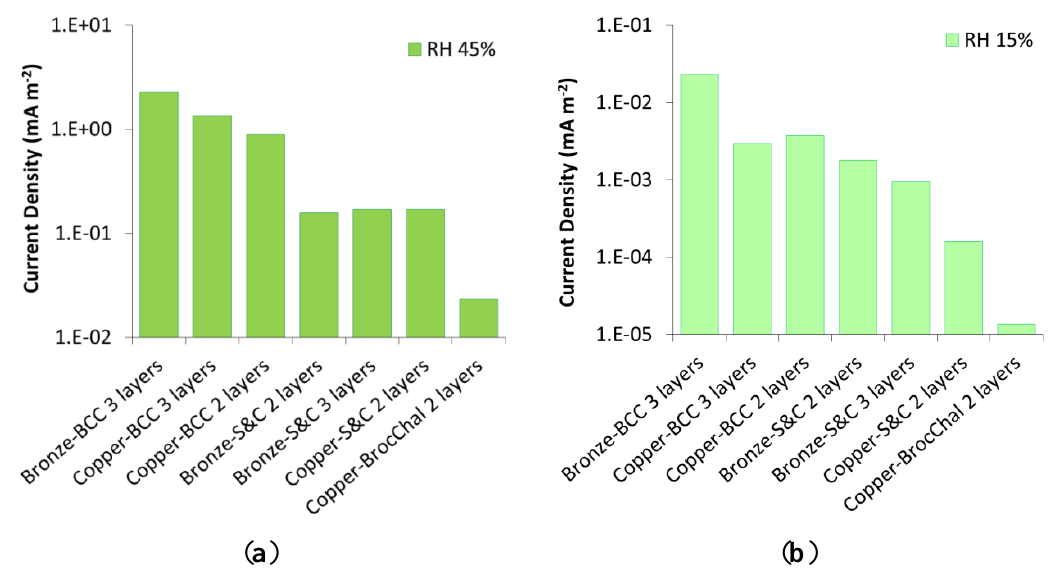
Figure 12. Average macrocouple current density as a function of the artificial patina composition and thickness, detected at constant temperature (25°C) during the fifth month of life of the galvanic sensors at RH% 45% ( a ) and 15% ( b